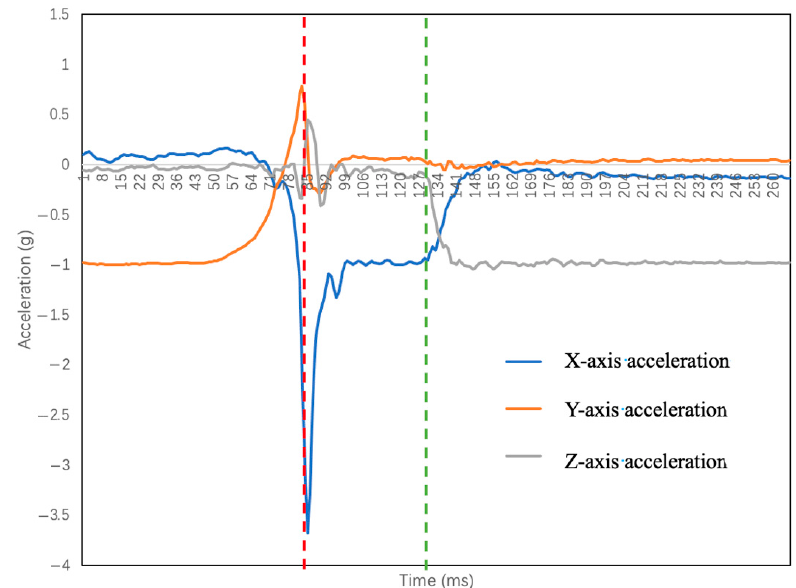
Figure 8. Fall to the right.